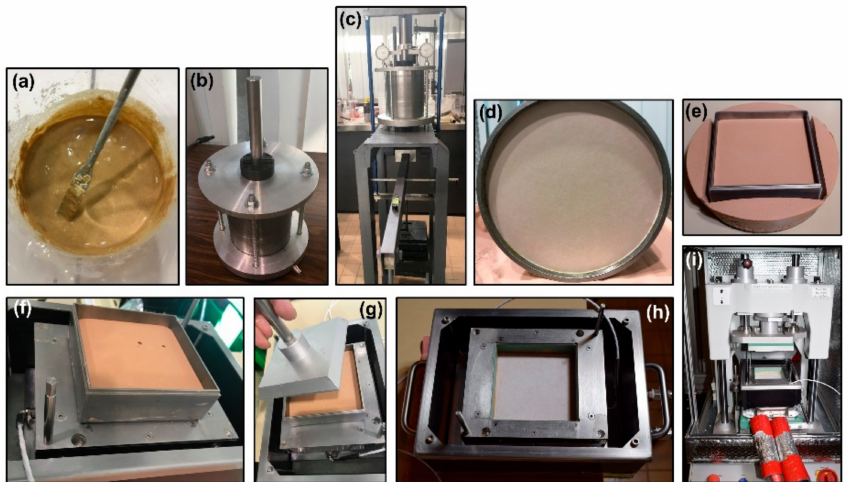
Figure 5. The procedure of preparing sand–clay mixture samples for interface direct shear tests: ( a ) slurry prepared by S1 mixing protocol, ( b ) installation of the sample into of the designed preconsoli- dation cell, ( c ) step preconsolidation on the oedometer frame, ( d ) uninstall the cell, ( e ) trimming the specimen with a cutter, ( f ) move to the shear box, ( g ) put the sample into the shear box with a rod, ( h ) after flatting put a filter paper and ( i ) move the shear box and container to the interface